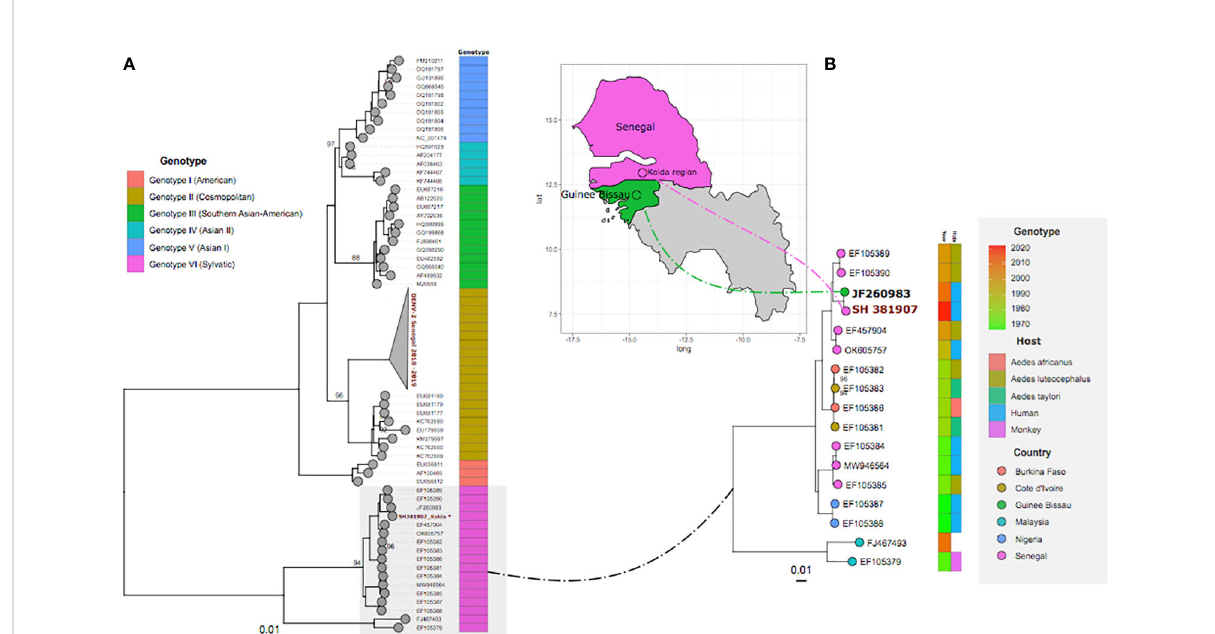
FIGURE 1 A maximum likelihood (ML) phylogenetic tree based on nearly complete genome sequences. Panel (A) shows that the obtained sequence used in this work belongs to the sylvatic genotype of dengue virus 2 (DENV-2). Panel (B) is an expansion of the sylvatic genotype (highlighted in grey on panel A ). The heatmap shows, respectively, the year of isolation and the host of used sylvatic DENV-2 strains during phylogenetic analysis. Tips are colored according to the country or provenance. The arrow shows the itinerary of the patient linked to sequence JF260983, who traveled to Guinea-Bissau through Senegal before returning to Spain where he was